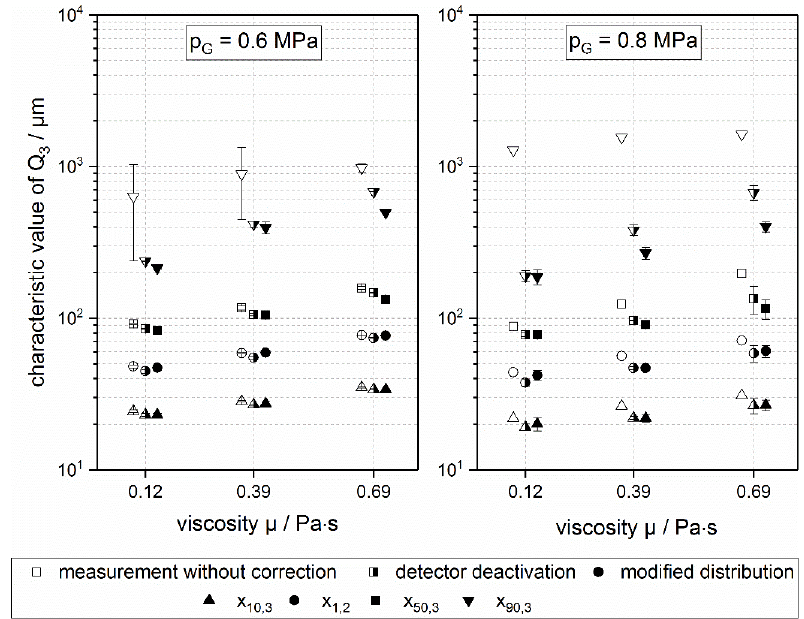
Figure 9: Characteristic values (x 10,3 , x 50,3 , x 90,3 , 𝑥̅ 1,2 ) of droplet size distributions, corrected by the method of detector deactivation (Det. off, empty symbols) and the new modification procedure (Mod., filled symbols) at different viscosities (0.12, 0.39, 0.69 Pa∙s) and gas pressures of 0.6 MPa ( left ) and 0.8 MPa ( right ).